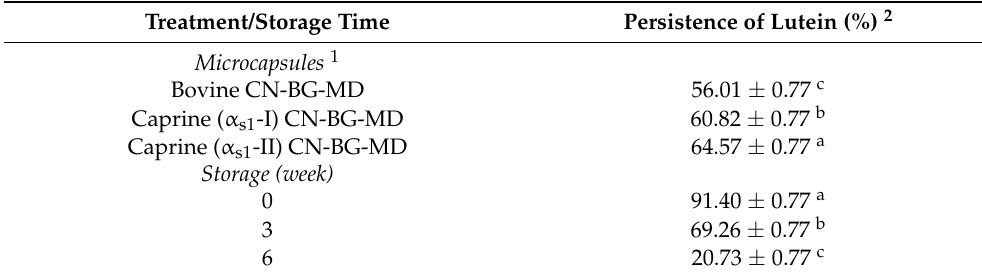
Table 3. Persistence of lutein in the lutein microcapsules during storage for 6 weeks at 20 ◦ C and 32% relative